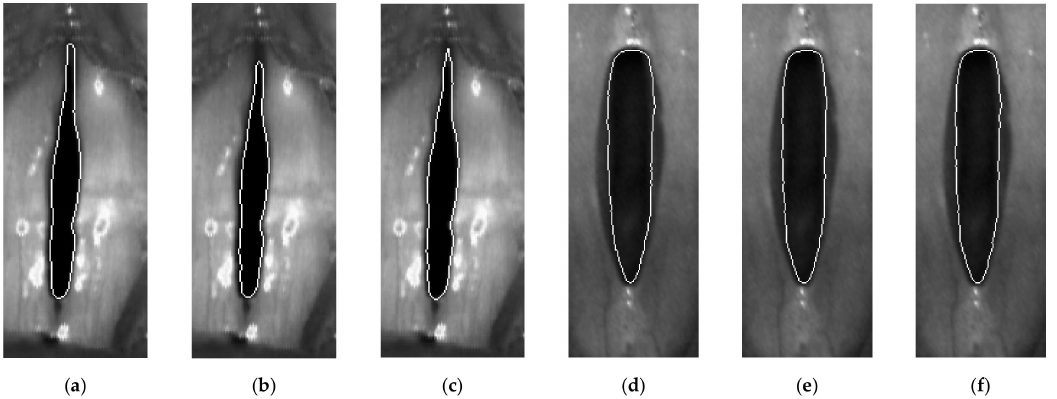
Figure 12. Example segmentations of the glottic images selected by the phoniatricians: images ( a – c ) are for the normophonic subject N10; ( d – f ) is for the patient I5 with glottal insuffi- ciency; images ( a ) and ( d ) are the results obtained for the optimum segmentation parameter set ( α * , β * ) minimizing cost function